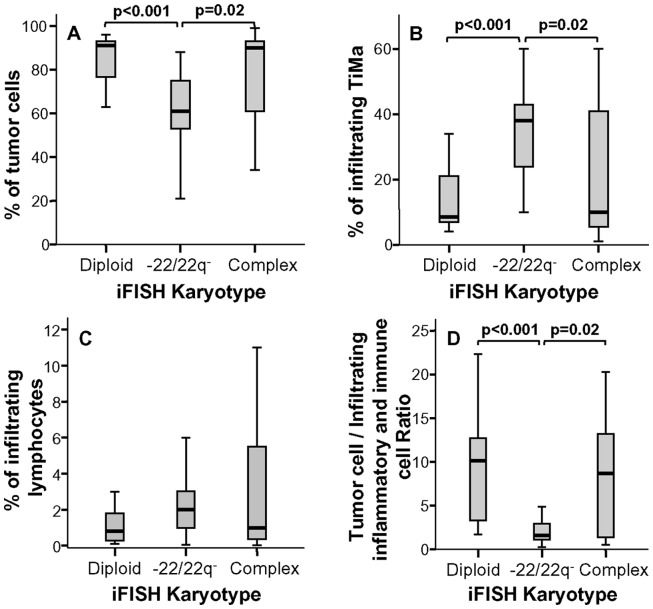
Distribution of tumor cells, inflammatory and other immune cells in meningioma samples classified according to the cytogenetic profile of the tumor.Percentage of tumor cells (panel A), tissue macrophages (TiMa) (panel B) and total lymphocytes infiltrating meningioma samples (panel C), grouped according to the cytogenetic iFISH profile of the tumor, are shown, as also the ratio between the number of tumor cells and all other infiltrating cells (panel D). Notched-boxes represent 25th and 75th percentile values; the lines in the middle and vertical lines correspond to median values and the 10th and 90th percentiles, respectively.